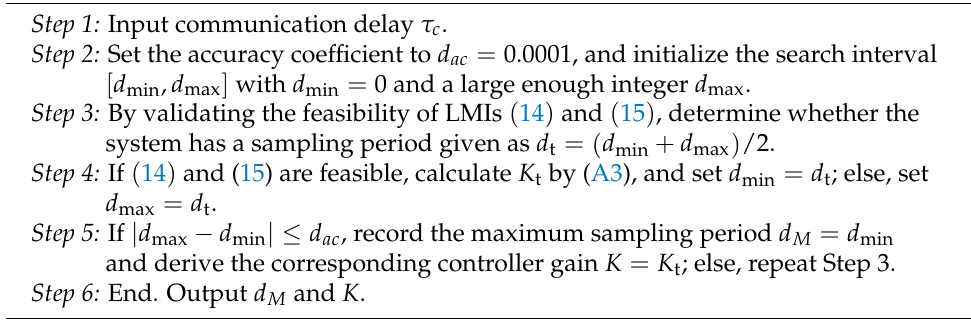
Algorithm 1 Find the maximum sampling period d M and the controller gain matrix K